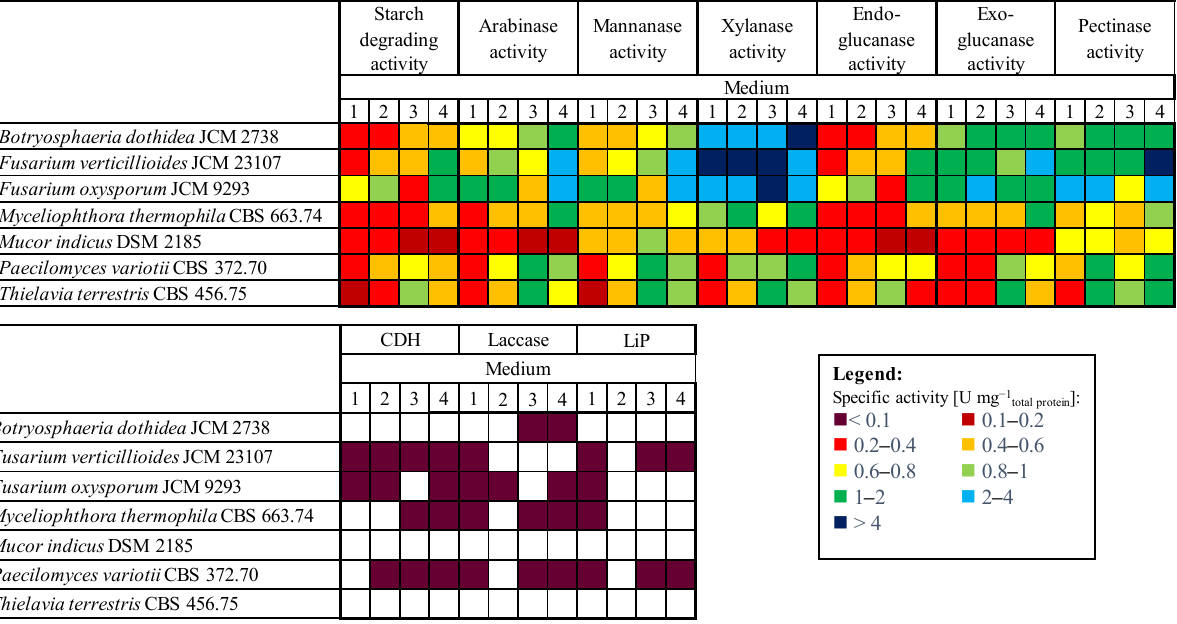
CDH Laccase LiP Medium 1 2 3 4 1 2 3 4 1 2 3 4